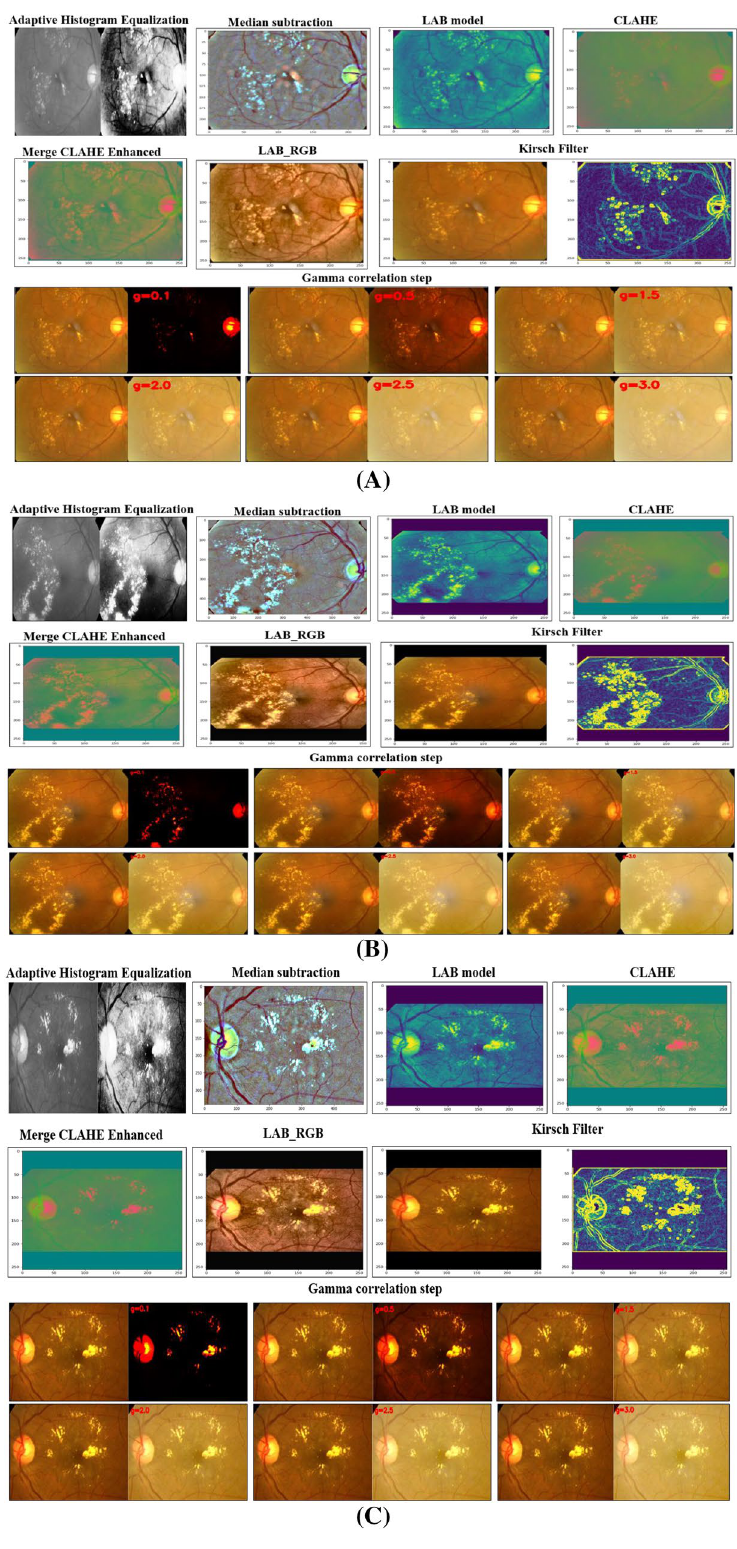
Figure 2. Preprocessing algorithm results ( A – C